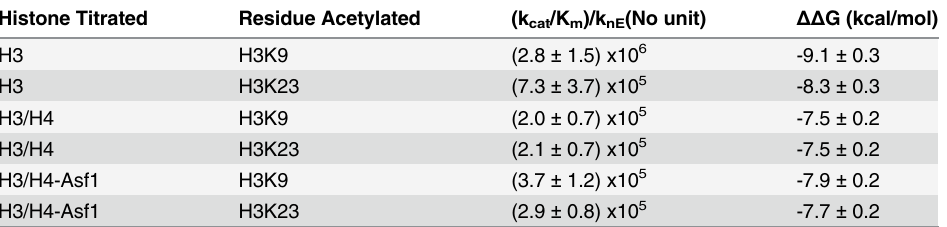
Table 3. Catalytic pro fi ciency of Rtt109-Vps75-mediated acetylation from histone titration (mean ± standard error). Histone